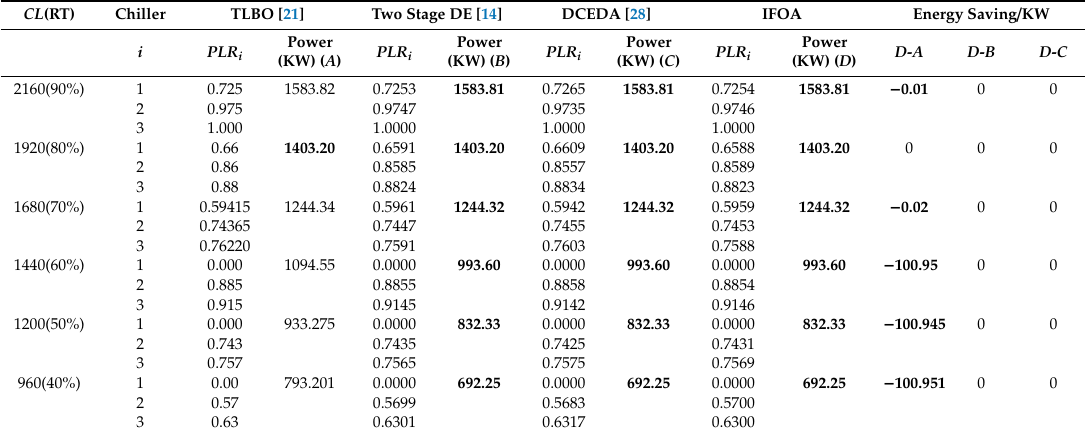
Table 9. The energy conservation of IFOA compared with TLBO, Two Stage DE and DCEDA in case 3. CL